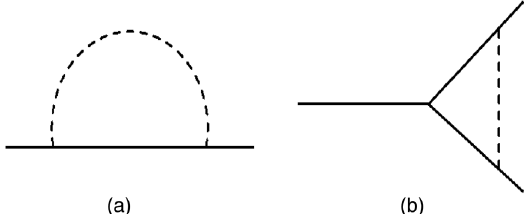
FIG. 9. One-loop (a) self-energy and (b) vertex diagram. Contributions from only these two diagrams are ultraviolet m − 1 expansion. Evaluations of these two divergent in ϵ m ¼ diagrams are shown in Appendix C. Here, solid (dashed) lines represent fermion (disorder)